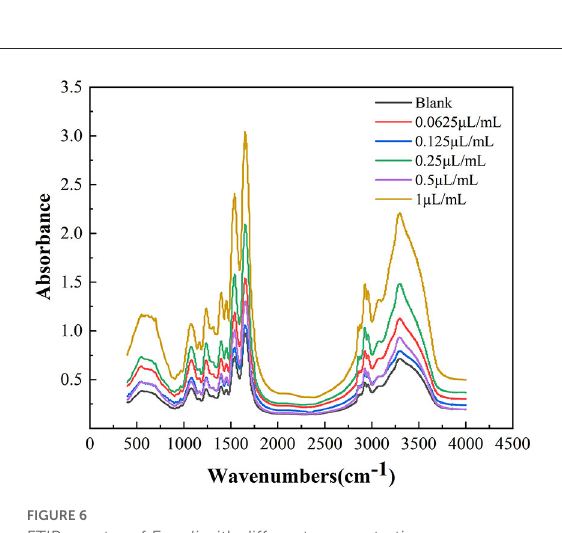
FIGURE6 FTIR spectra of E. coli with different concentration